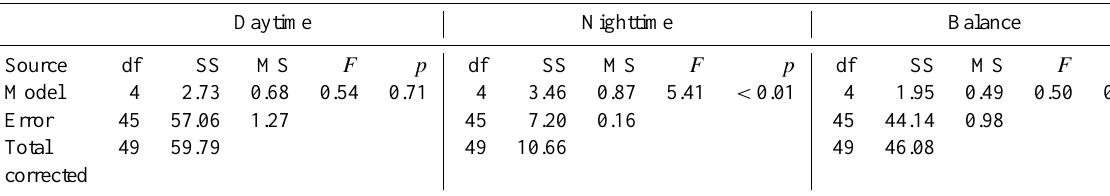
Table 3. Summary of ANOVA table for daily NEE daytime , NEE nighttime , and NEE balance contrasting land use change types in the shortgrass steppe in central Mexico. Factors included in the model term are site (exclosure, shrub encroachment, overgrazing, moderate grazing, crop), time of day (TOD; 08:00, 12:00, 16:00 and 20:00LT), date (October, November, January, February, March, May, June, July, August and September).